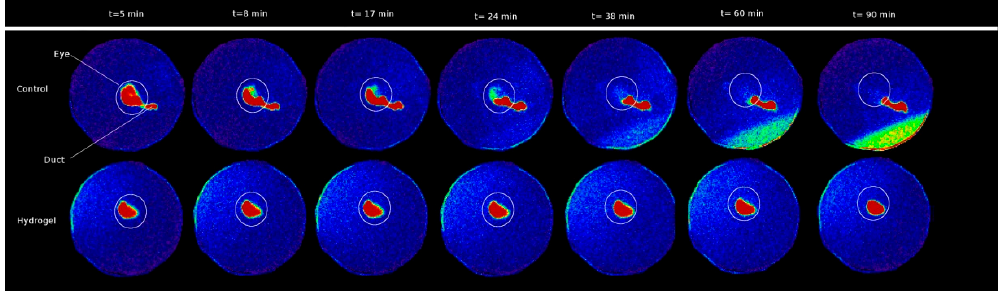
Figure 6. Scintigraphy image of a novel ion-sensitive hydrogel based on gellan gum and kappa-carrageenan. In the upper images (control eye), the signal decreases in the corneal surface, moving towards the nasolacrimal duct, while in the bottom images, signal obtained in the eye with hydrogel remains unchanged. Reproduced with permission from [51], published by Elsevier, 2017.